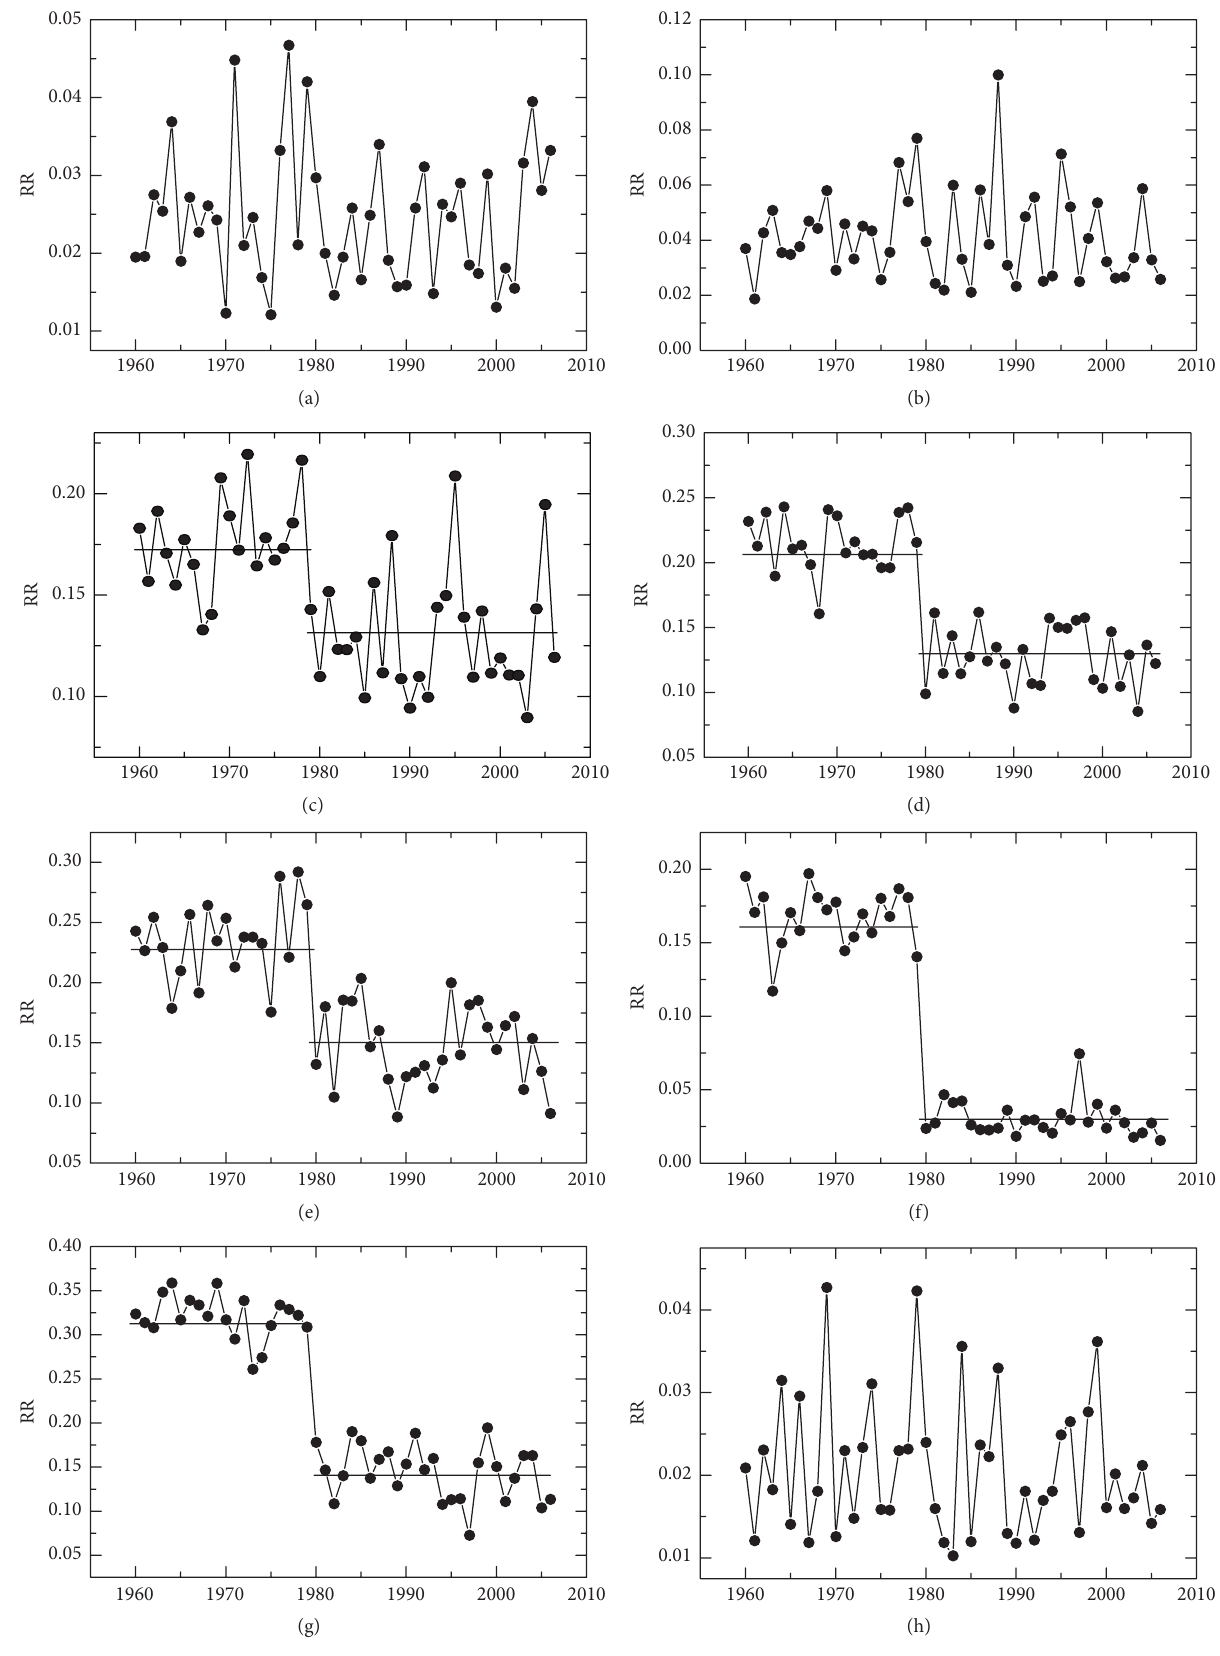
Figure 4: The charts of annual changes of precipitation RR of each region in